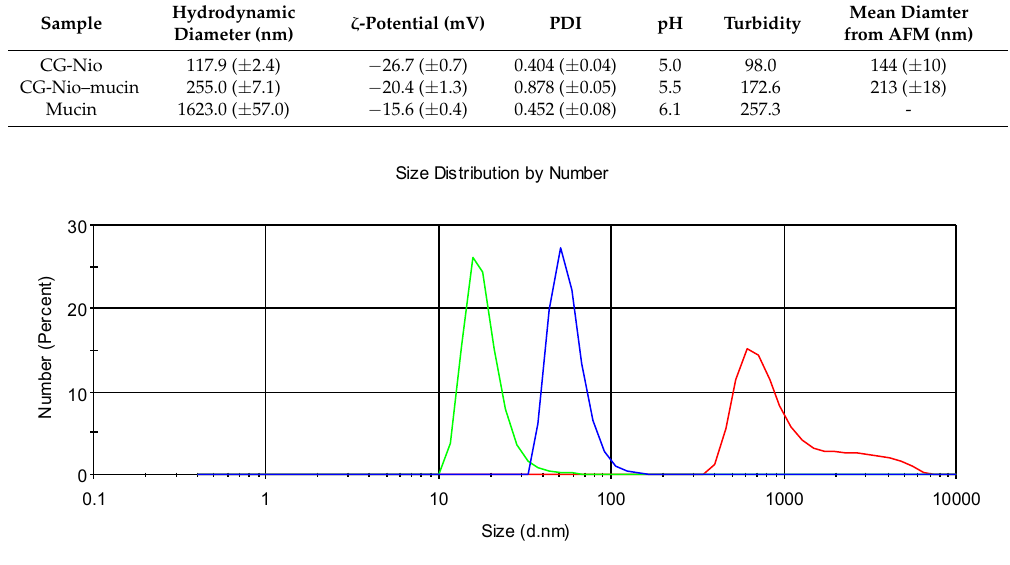
Figure 5. Particle number weighted size distribution of CG-Nio (green), CG-Nio–mucin mixture (blue), and mucin solution (red).